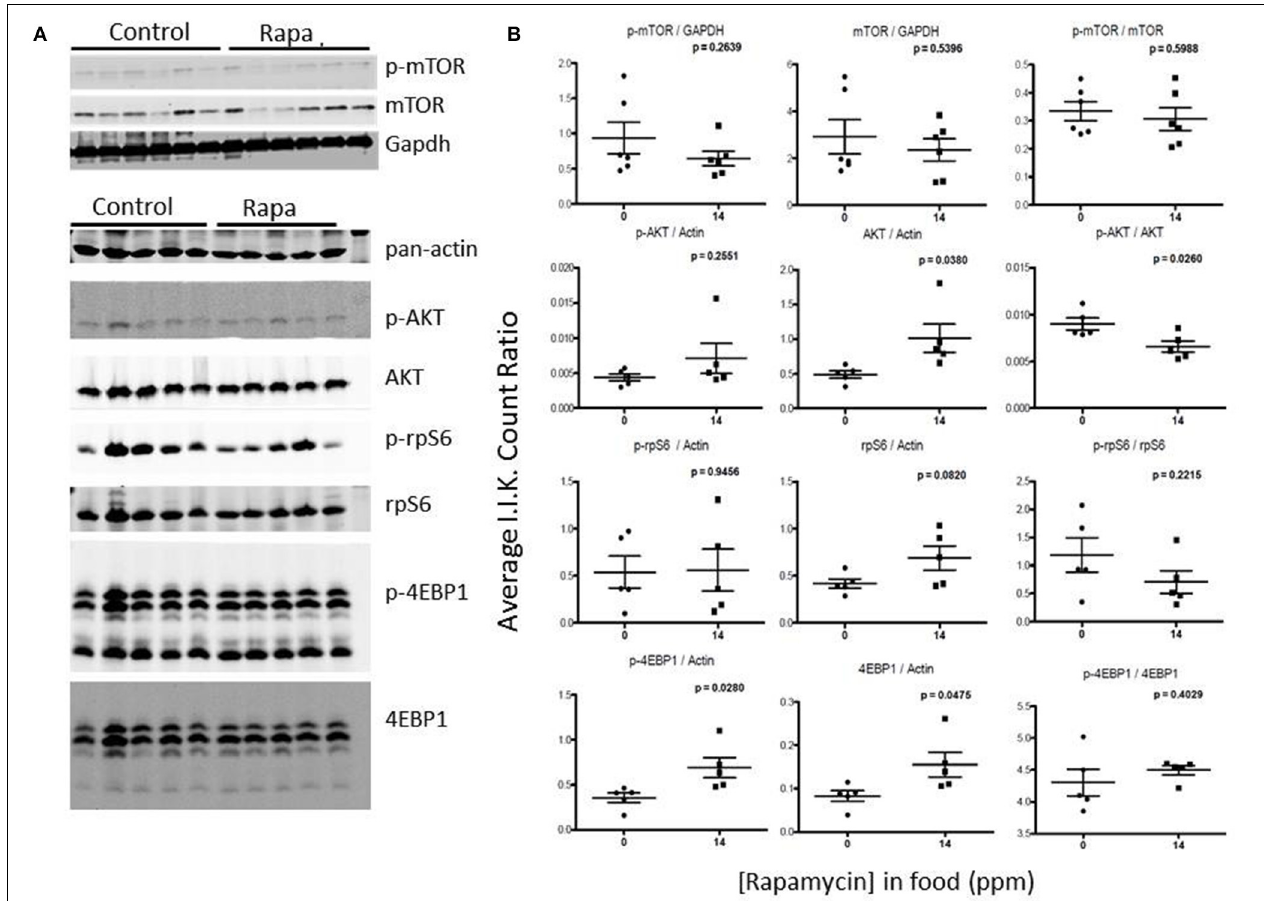
FIGURE 8 | Liver lysates from male C57BL6 mice also did not show a clear pattern of change in mTOR signaling. (A) Western blots from lysates from 25 month-old males and